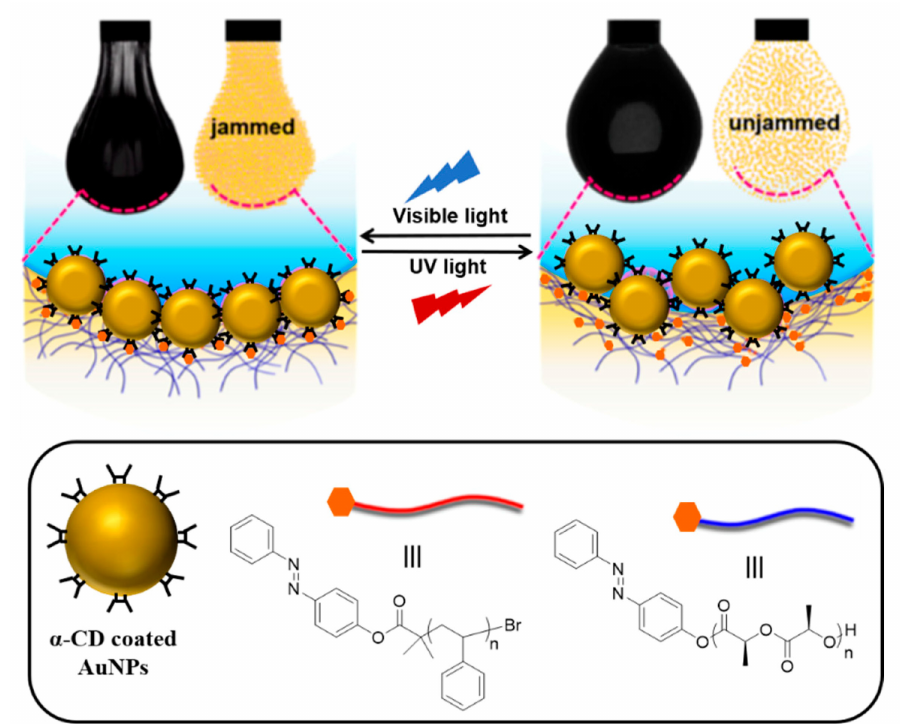
Scheme 17. Photo-responsive NPS at the oil–water interface switching from the jammed state to the unjammed state reversibly. Adapted with permission from Ref. [82]. Copyright 2020, American Chemical